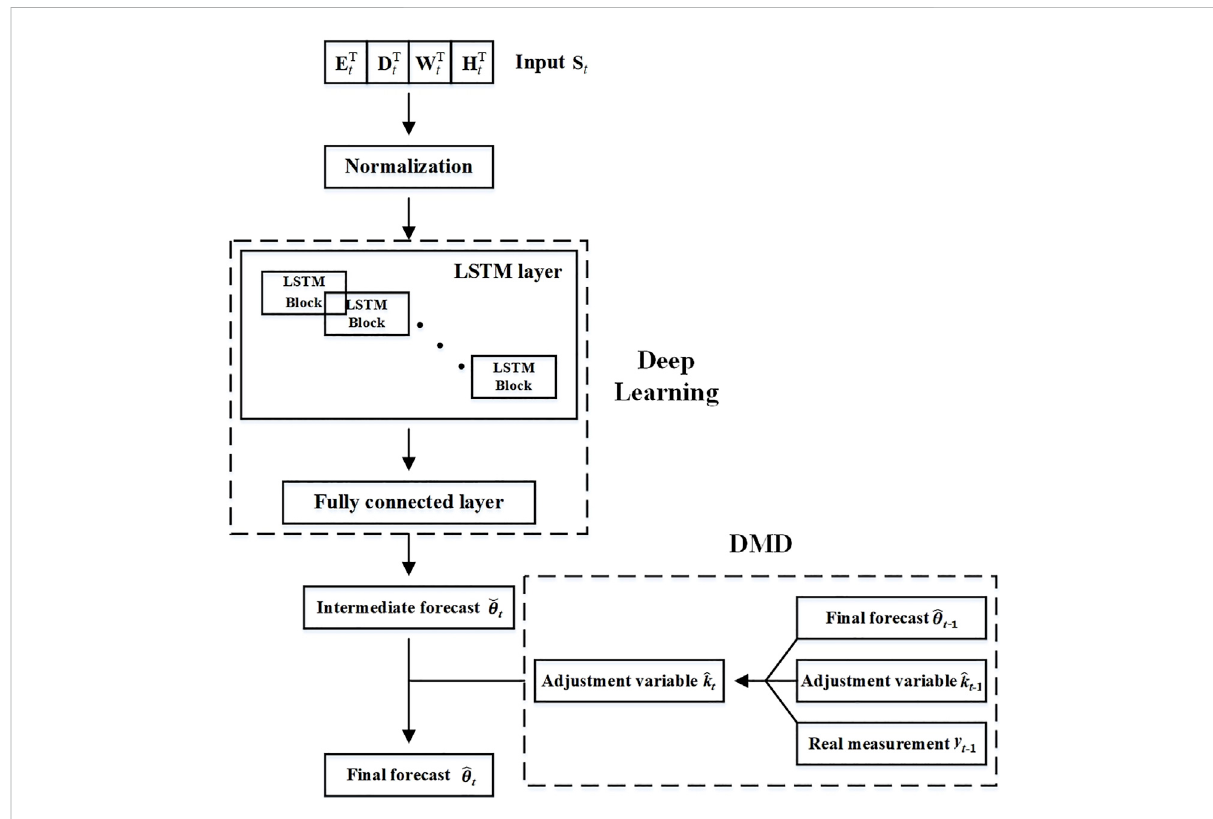
FIGURE 1 Framework of integration of deep learning and dynamic mirror descent for adaptive individual residential load forecasting.